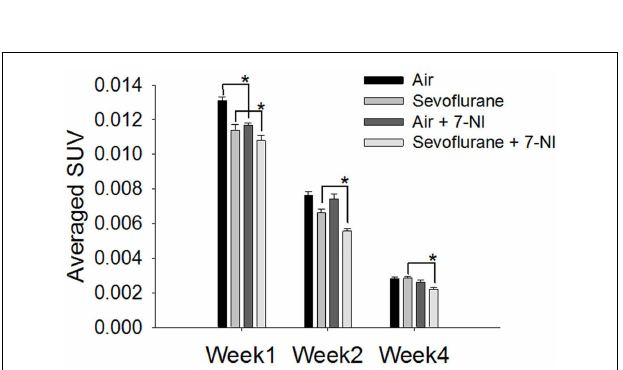
FIGURE 3 | Co-administration of 7-NI induced inhibition upon [ 18 F]FLT uptake in the hippocampal regions in either air- or sevoflurane- exposed rats . On PND 7, the rats ( n = 5) were treated with 7-NI i.p. (30mg/kg body weight, dissolved in corn oil) 18 and 1h prior to and 4h following the beginning of 9h-exposure to either sevoflurane or air. One, 2, and 4weeks after exposure the animals were assessed via microPET 30min after the injection of [ 18 F]FLT i.p. (18.5MBq/dose). In week 1, the [ 18 F]FLT uptake of the hippocampus region in rats co-administrated with 7-NI was significantly lower than those in rats exposed to either air ( p = 0.00006) or sevoflurane ( p = 0.0427) only. In week 4 after exposure, the SUV in sevoflurane-exposed plus 7-NI group remained significantly lower than that of group exposed to sevoflurane only ( p = 0.0077, Dunnett’s test). SUVs are presented as means ± SEM, asterisks denote significant differences in [ 18 F]FLT uptake between the rats co-administrated 7-NI and those exposed to air or sevoflurane alone in weeks 1, 2 or 4 after exposure (* p < 0.05, repeated measures linear mixed effect model, Dunnett’s test for multiple